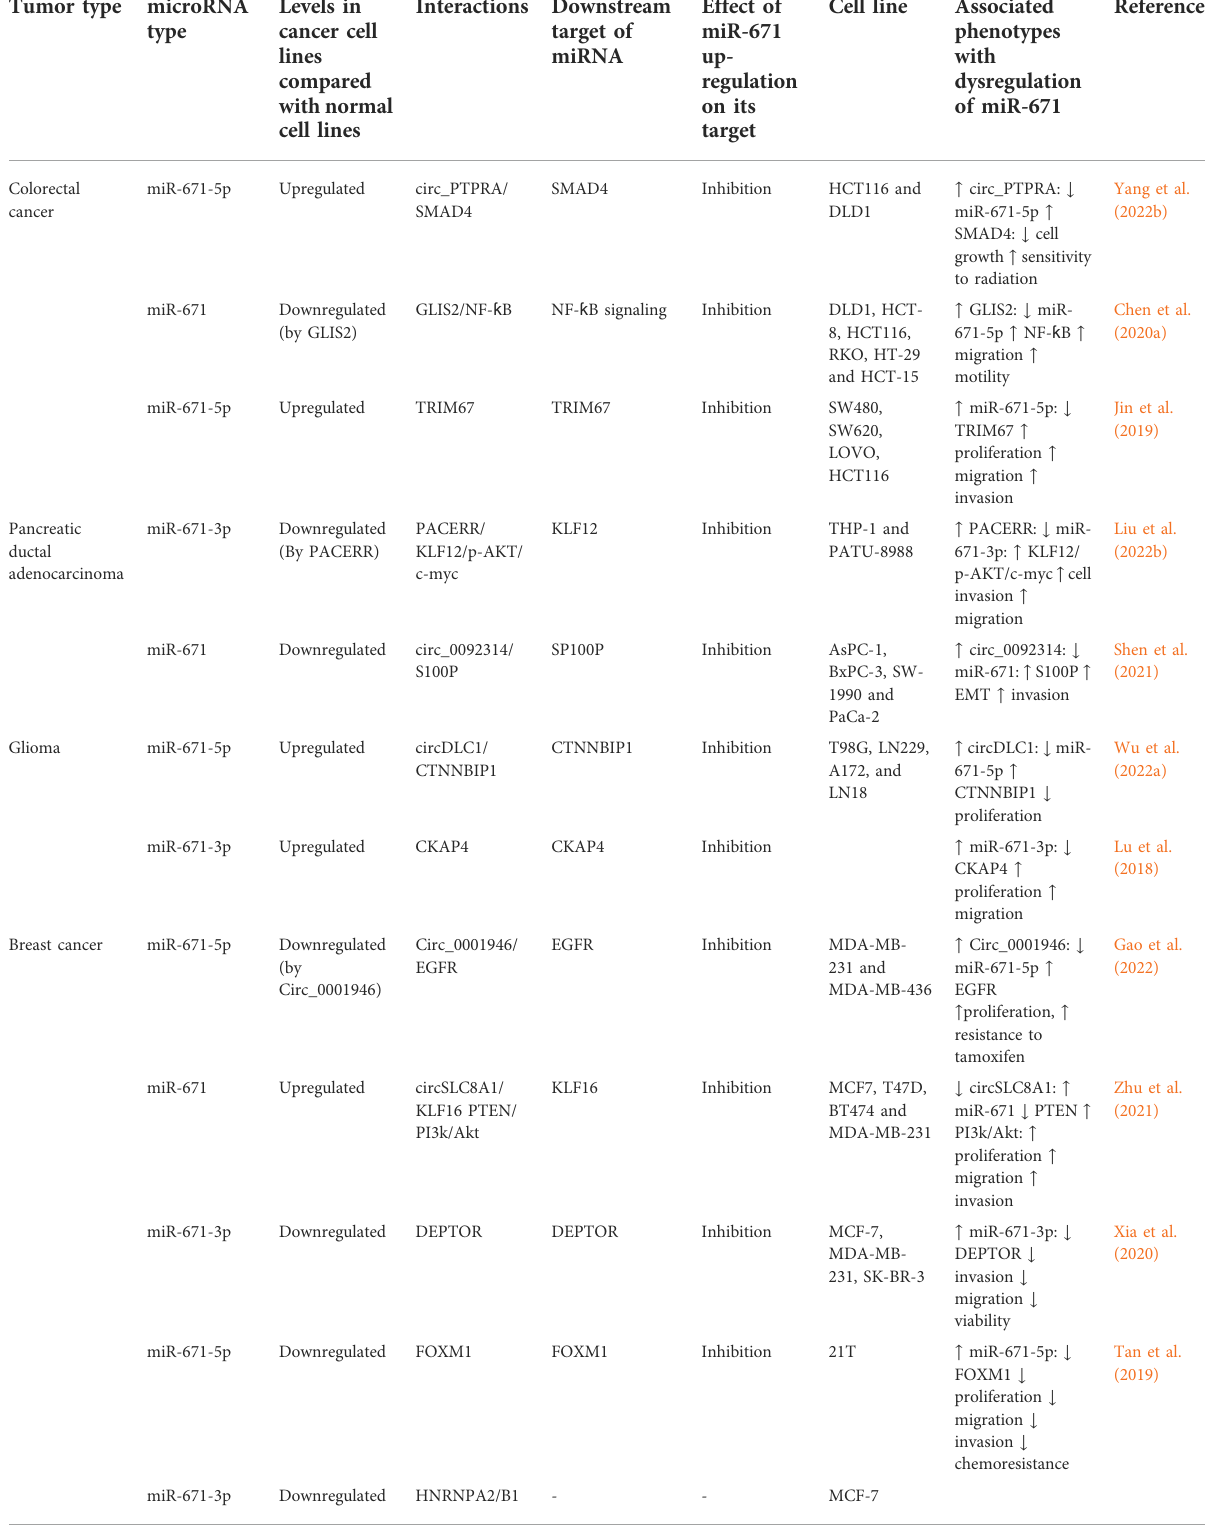
TABLE 1Function of miR-671 in cancercell lines(Arrows indicate the effects of changes in theexpression ofmentioned genes (either endogenousor exogenous). Δ : knockdown or downregulation, MPP+: